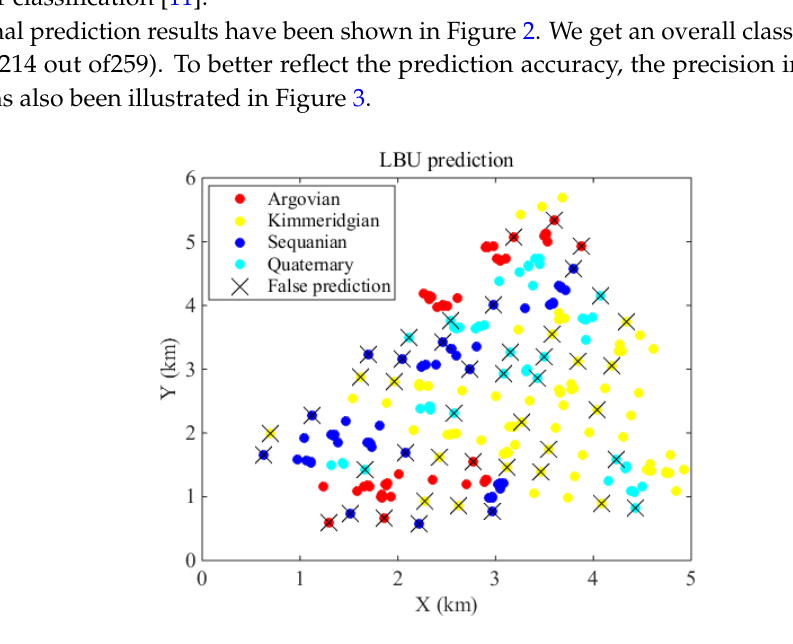
Figure 2. Lithofacies prediction of the corresponding 259 locations based on MAP probability criterion.